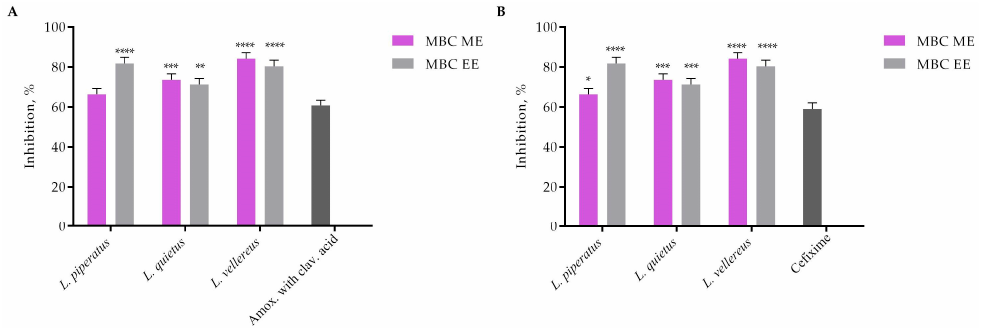
Figure 2. Destruction of S. aureus 24 h preformed biofilm after 30 s treatment with Lactarius extracts compared with commercial drugs: ( A ) amoxicillin with clavulanic acid; ( B ) cefixime. The error bars indicate standard deviations. The asterisks represent statistical significance *, p ≤ 0.05; **, p ≤ 0.01; ***, p ≤ 0.001, ****, p ≤ 0.0001, the data are presented as mean ±